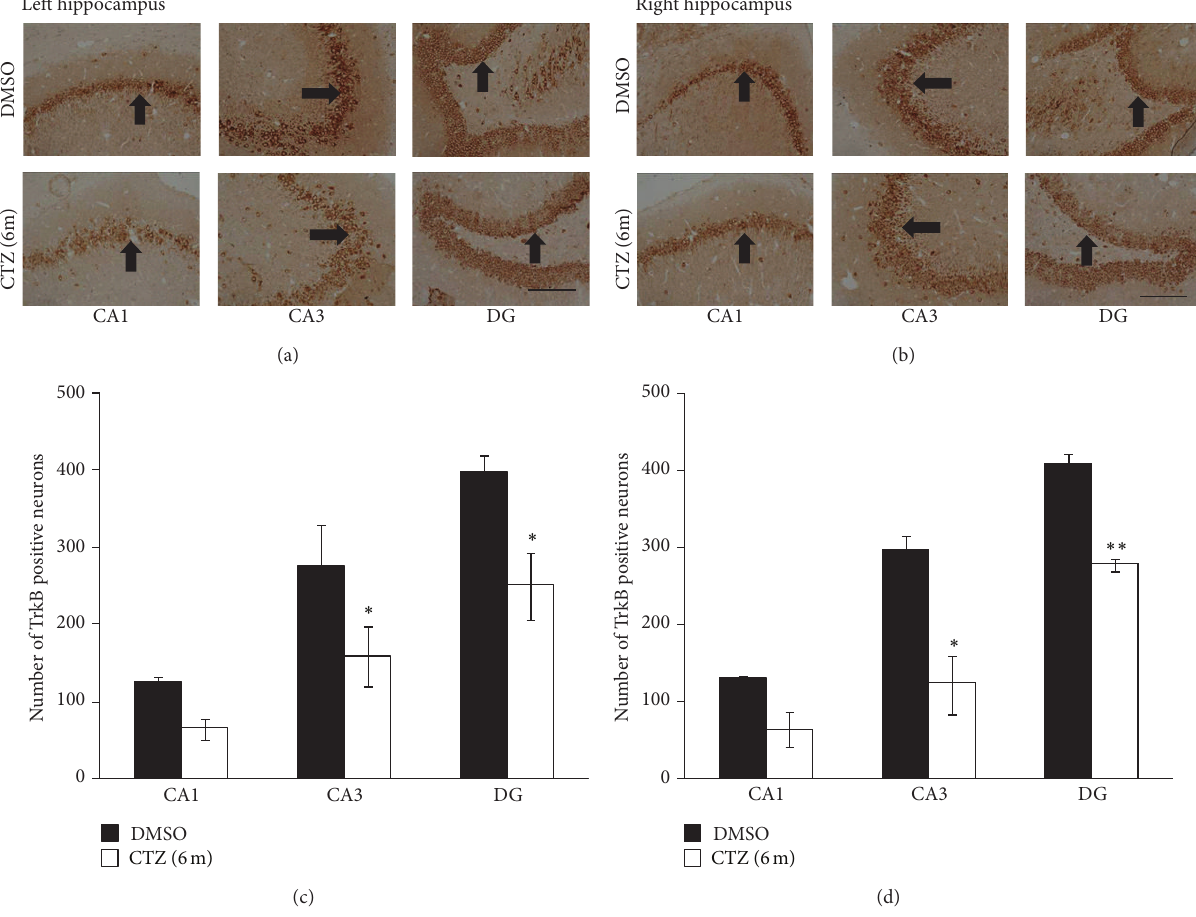
Figure 7: Decreased TrkB staining in hippocampus of recurrent seizure rats induced by CTZ. (a-b) Pictures showing TrkB positive cells (arrow indicated) in left (a) and right (b) hippocampus from rats 6 months after either DMSO (top) or CTZ (bottom) treatment. (c-d) Group data showing significant decreases of the TrkB staining cells in CA1, CA3, and DG area of the hippocampus from rats 6 months after either DMSO ( 𝑛 = 3 ) or CTZ ( 𝑛 = 3 ) treatment. ∗ 𝑃 < 0.05 , ∗∗ 𝑃 < 0.01 , compared to the DMSO control group. Scale bar in (a) and (b): 200 𝜇